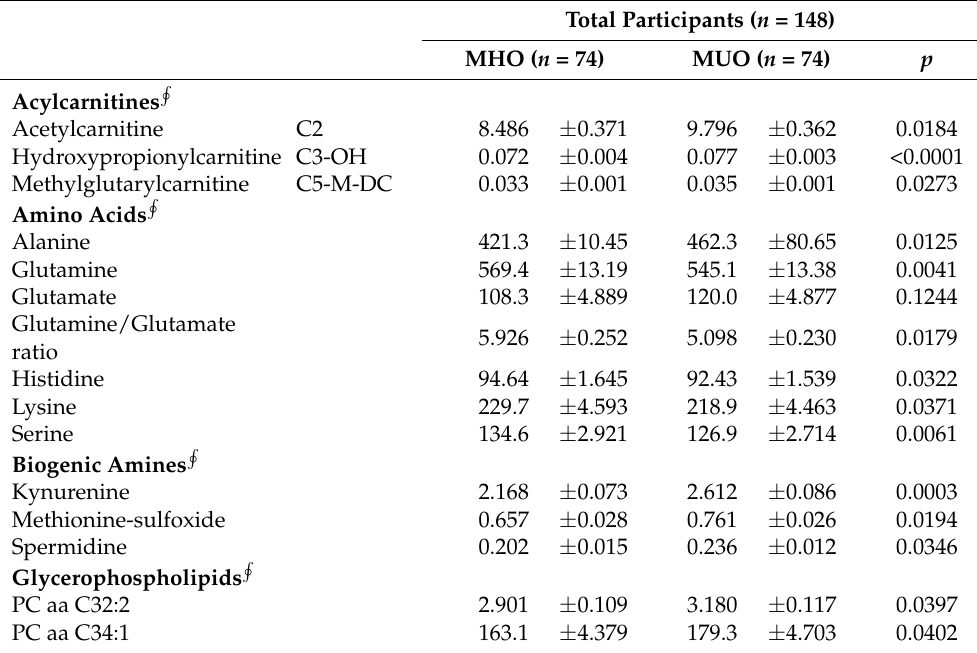
Table 2. The metabolites of MUO and MHO in